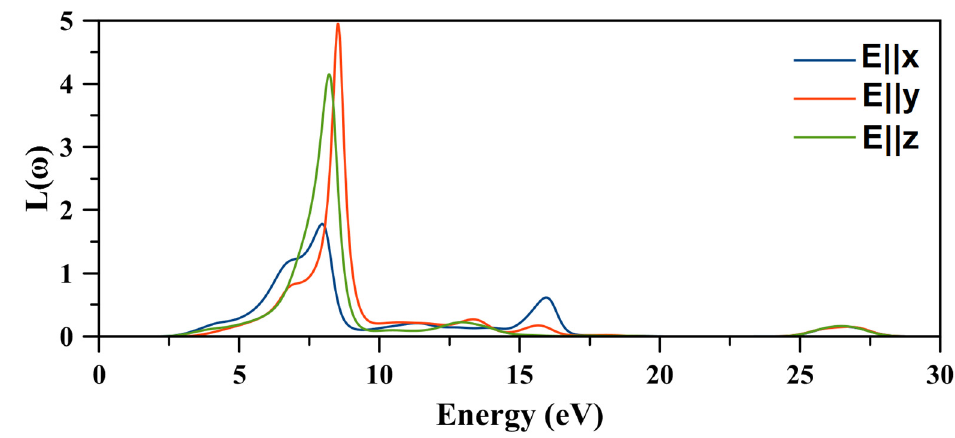
Figure 16 . Energy-loss spectrum of the (C 2 H 7 N 4 O) 2 BiCl 5 compound.